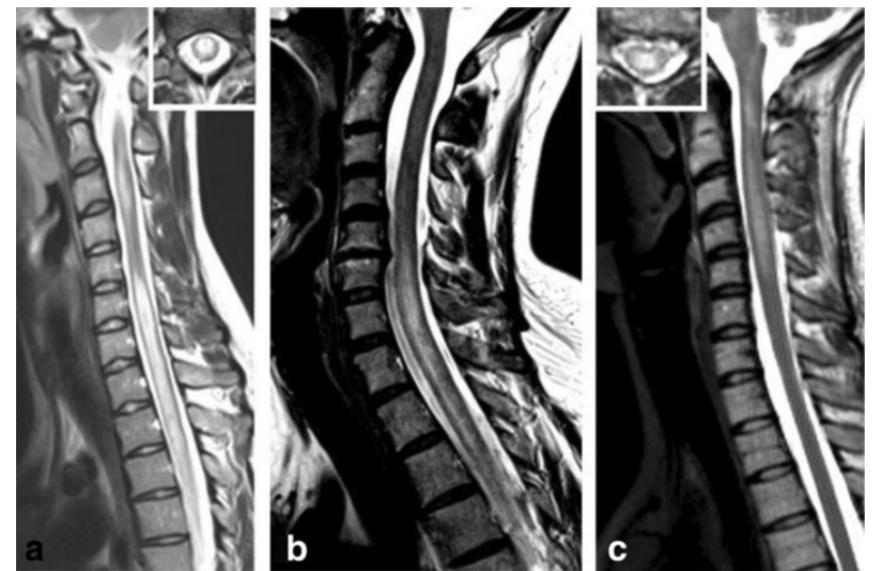
Figure 3. Anti-myelin oligodendrocyte glycoprotein (MOG) antibody myelitis. ( a ) Sagittal T2-weighted spinal MRI performed at disease onset revealed a large longitudinal centrally-located lesion extending over the entire spinal cord, as well as swelling of the cord. ( b ) Longitudinally extensive central spinal cord T2 lesion in another patient. ( c ) T2-hyperintense lesions extending from the pontomedullary junction throughout the cervical cord to C5, in a third patient. Insets in ( a ) and C show axial sections of the thoracic cord at lesion level [172]. Figure is extracted from Jarius, S. et al., J Neuroinflammation 2016, 13 , 280 (http://creativecommons.org/licenses/by/4.0/).